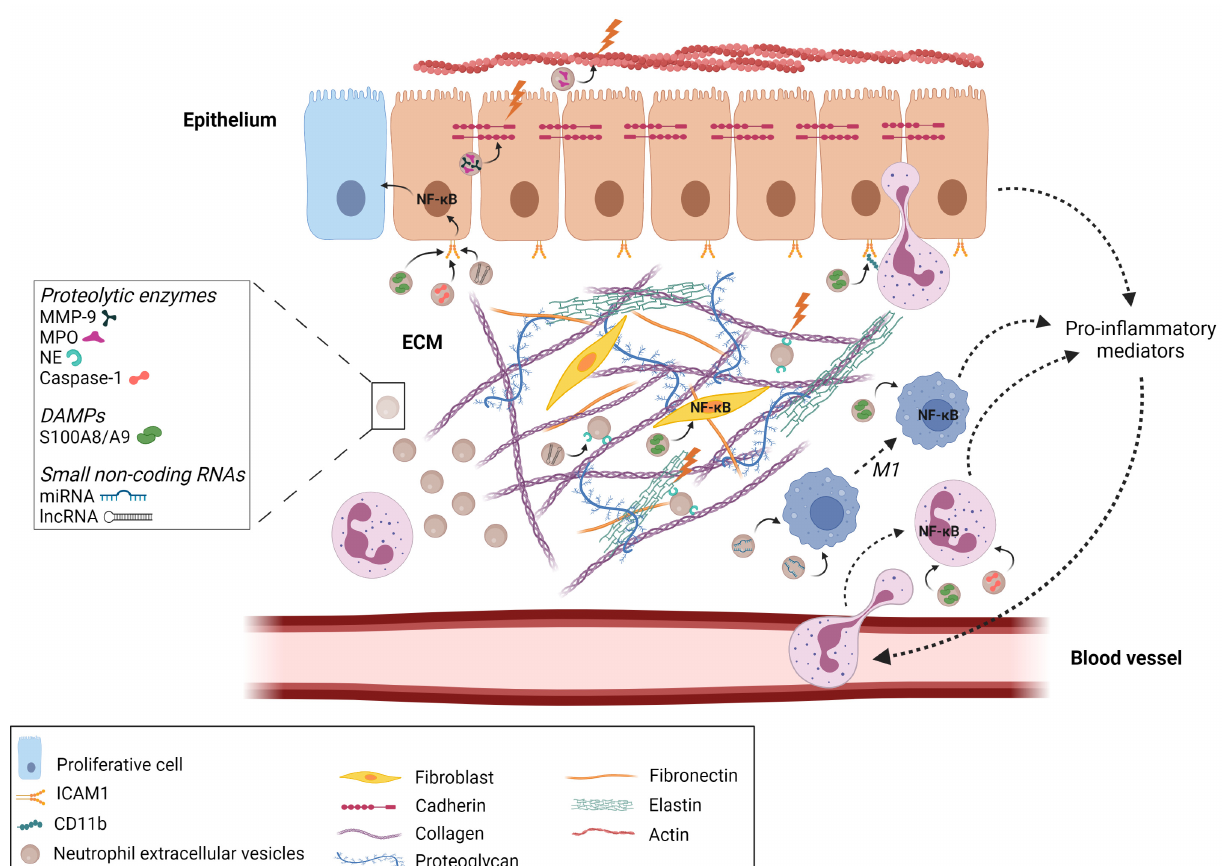
Figure 2. Overview of neutrophil extracellular vesicle functions involved in inflammation-inducing disease pathogenesis. Upon activation with inflammatory mediators, neutrophils rapidly release a set of extracellular vesicles into their local environment. Proteolytic enzymes (myeloperoxidases, MPO; neutrophil elastase, NE; and metalloproteinase 9, MMP-9) packaged in nEVs degrade extracellular matrix (ECM) components, disrupt the cadherin junction, and regulate actin dynamics, increasing epithelial cell permeability and facilitating immune cell invasion. Long noncoding RNA (CNRDE) can accentuate the degradation of ECM by increasing NE activity. Moreover, caspase-1 can induce the release of proinflammatory mediators by epithelial cells as well as increase ICAM-1 expression. The binding between epithelial cells and neutrophils is facilitated by S100A8/A9, which can increase the expression of CD11b on rolling neutrophils. S100A8/A9 is also able to induce NF- κ B signaling in resident and infiltrated cells, resulting in an amplification of the inflammatory response through the recruitment of supplementary neutrophils. In addition, miRNAs contained in nEVs can polarize macrophages towards the proinflammatory M1 phenotype participating in the amplification loop of the inflammatory process. All figures were created using Biorender (https://biorender.com, accessed on 21 April 2021).